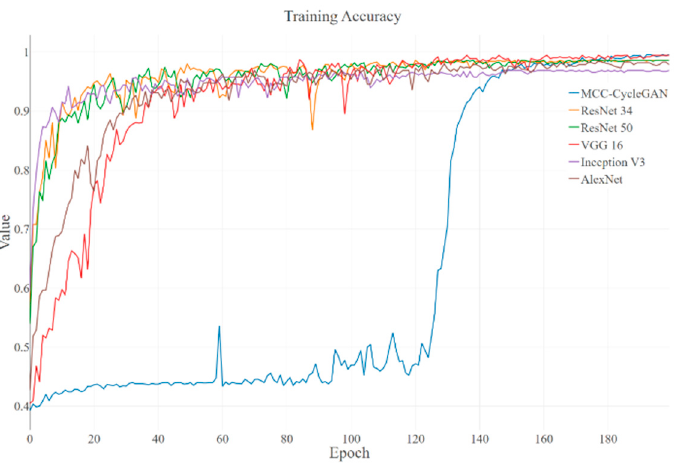
Figure 7. The training accuracies of the MCC-CycleGAN and other classical algorithms. The accuracies have the corresponding tendency with the losses. The accuracy of the proposed MCC-CycleGAN start to rise at epoch 130 and obtain similar accuracy compared to other contrastive networks. Table 2. The description of the image dataset A and B.